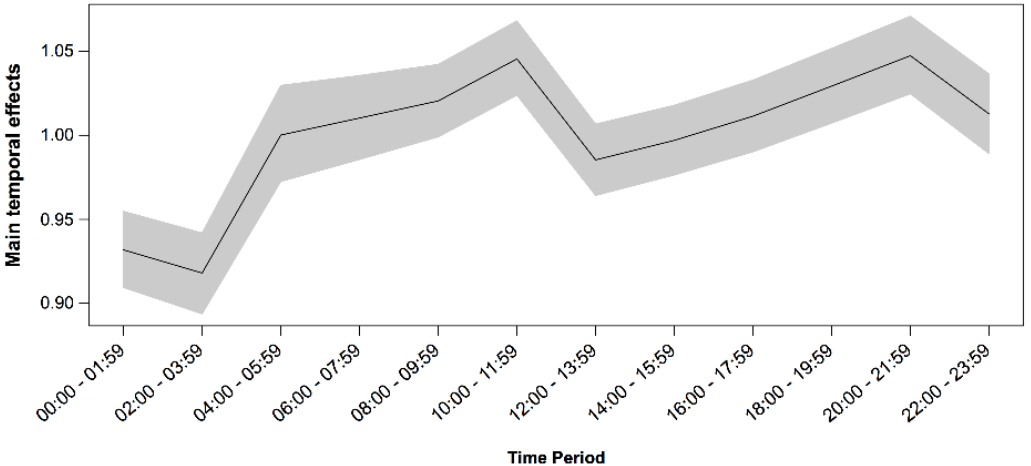
Figure 4. Main temporal effects (= exp( γ t + φ t )) for calls-for-service. Grey indicates 95% credible interval (CI).